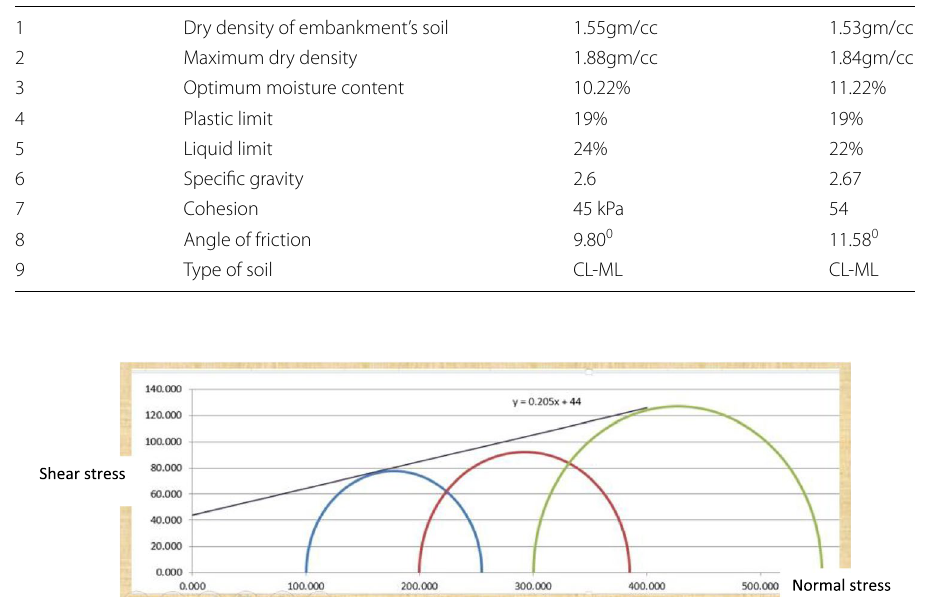
Fig. 2 Mohr’s Failure Envelope